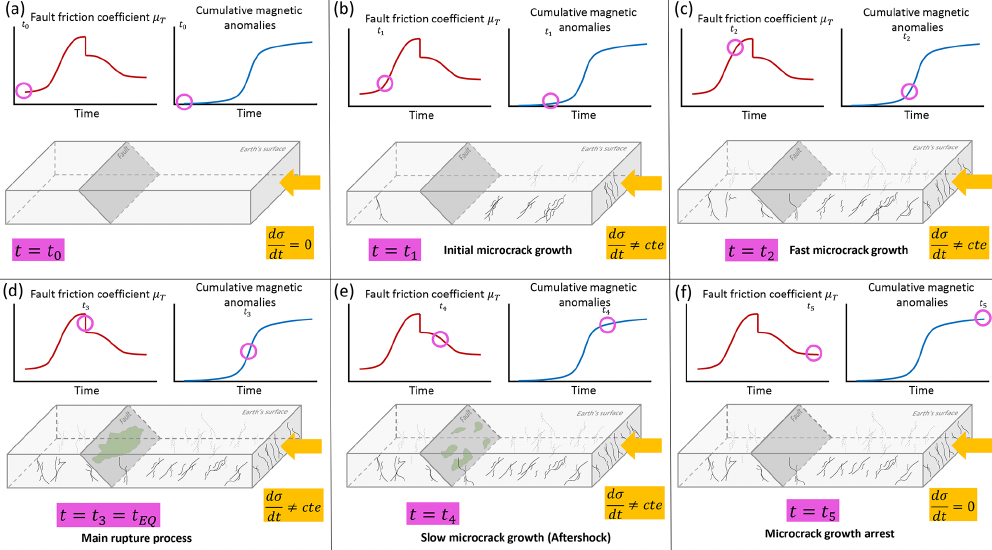
Figure 10. Schematic representation of the seismo-electromagnetic theory. The anomalies generation are owing the creation of several microcracks. The number of cracks increase because the internal collapse of the lithosphere when a non-constant uniaxial stress is applied.